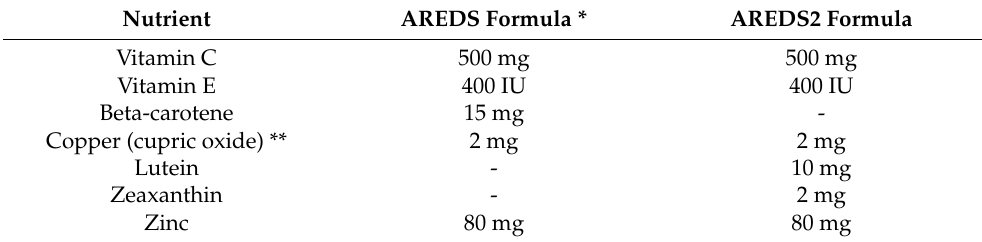
Table 4. Commercially available formulas based on AREDS and AREDS2. Nutrient AREDS Formula * AREDS2 Formula Vitamin C 500 mg 500 mg Vitamin E 400 IU 400 IU Beta-carotene 15 mg - Copper (cupric oxide) ** 2 mg 2 mg Lutein - 10 mg Zeaxanthin - 2 mg Zinc 80